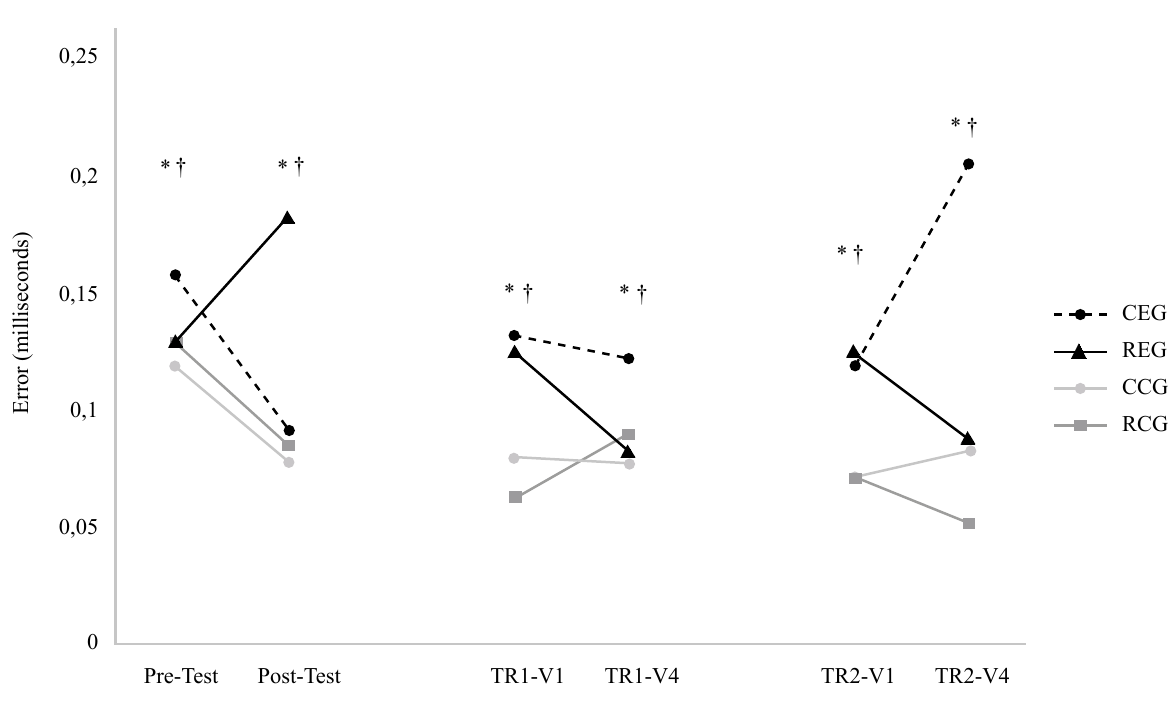
Figure 3= Mean of the variable error along blocks of trials for all groups. Legend: CEG – Constant Experimental Group, REG – Random Experi - mental Group, CCG – Constant Control Group, RCG – Random Control Group, TR1 – Immediate Transfer Test, TR2 – Long Term Transfer Test, V1 – Speed at 1 mph, V4 – Speed at 4 mph, * - Significant difference between REG and RCG, † - Significant difference between CEG and